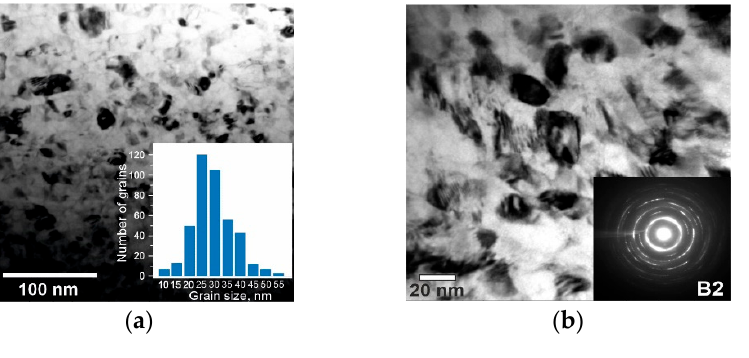
Figure 2. TEM images of the nanocrystalline structure of the NiTi wire with a thickness of 60 µm with the corresponding diffraction pattern from the B2 phase: ( a ) wire matrix structure and grain size distribution histogram; ( b ) magnified view of the wire matrix structure with the corresponding diffraction pattern; ( c ) dark-field image of the wire matrix structure.